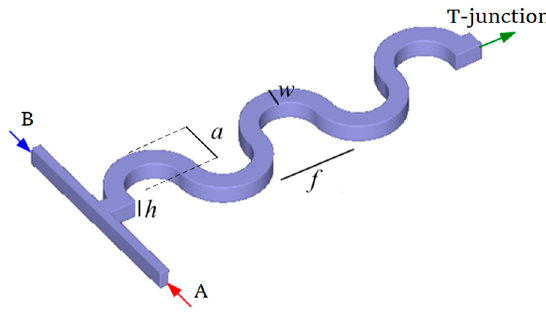
Figure 1. Schematic of micromixer T-junction with wavy structure.